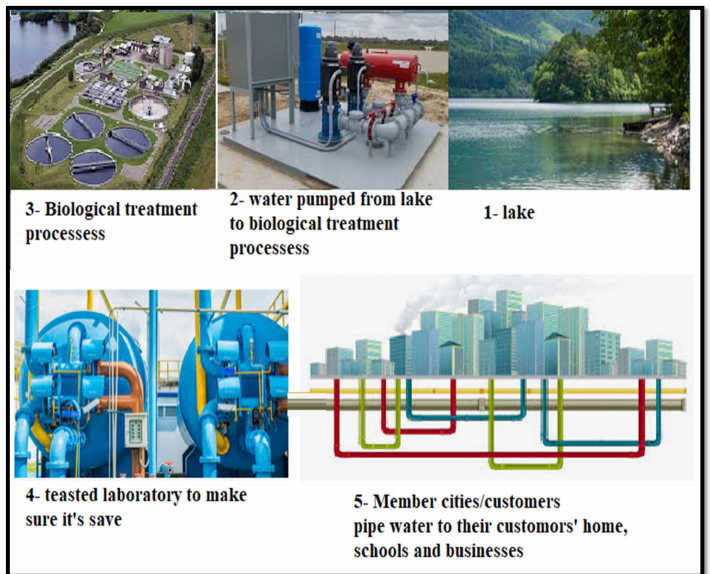
Figure 1. Block diagram of wastewater treatment facility